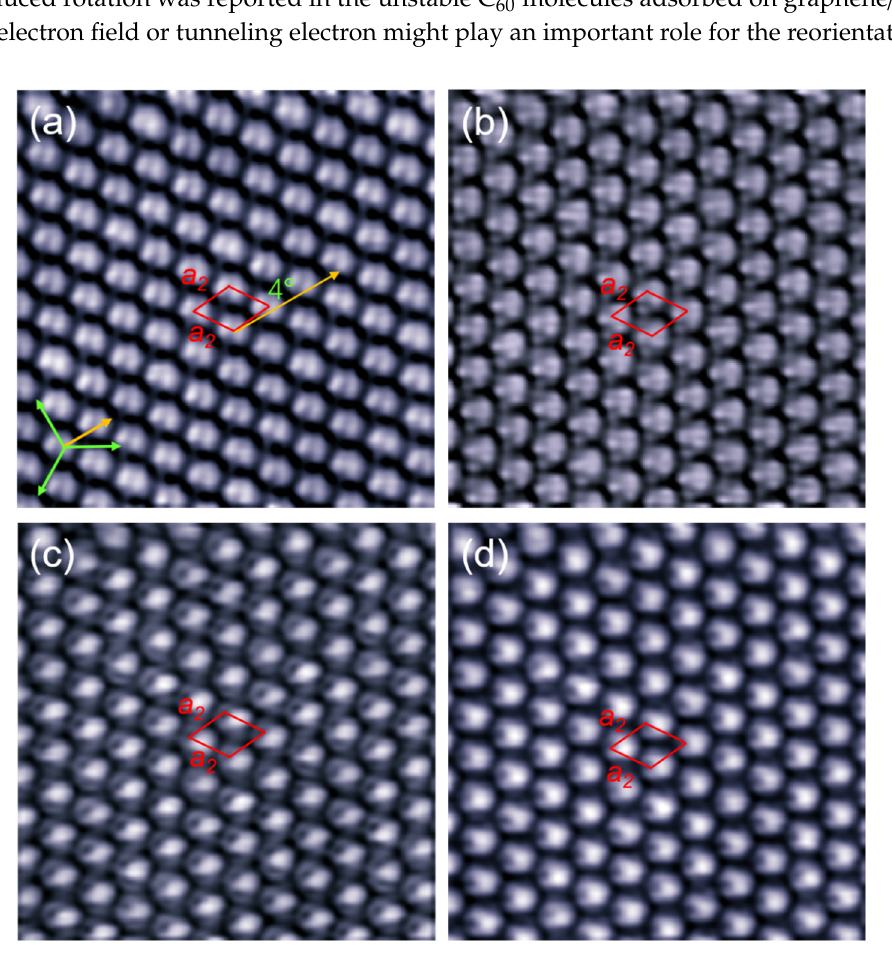
Figure 3. Bias-dependent STM images (10 nm × 10 nm) of the C 60 monolayer in the R26° domain. The bias voltages in ( a – d ) are 1.4, 0.6, − 1.4, and − 2.0 V, respectively. All the tunneling currents are 30 pA. All the C 60 molecules are arranged in the same orientation. The individual C 60 molecules reveal sub-molecular contrast such as the two parallel lobes in (a), a small hole and a bright oval in (c), and a bright ball with small opening in (d).